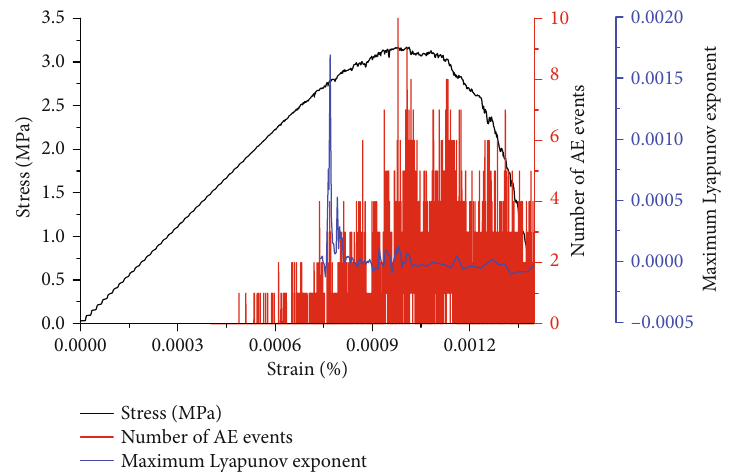
Figure 13: Stress-strain-number of AE events-maximum Lyapunov exponential variation diagram of specimen